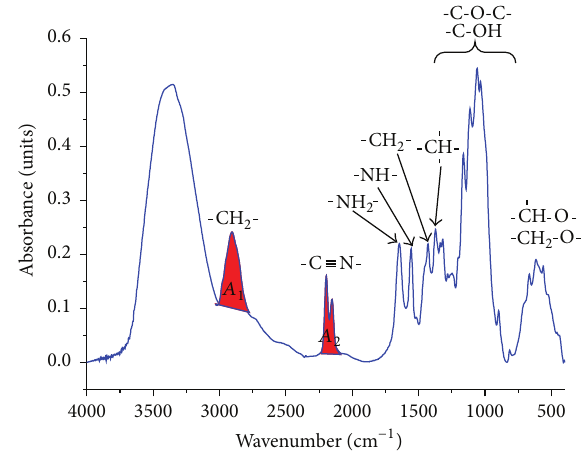
Figure 3: Defined areas 𝐴 1 and 𝐴 2 corresponding to -CH 2 - and C ≡ N absorption bands,